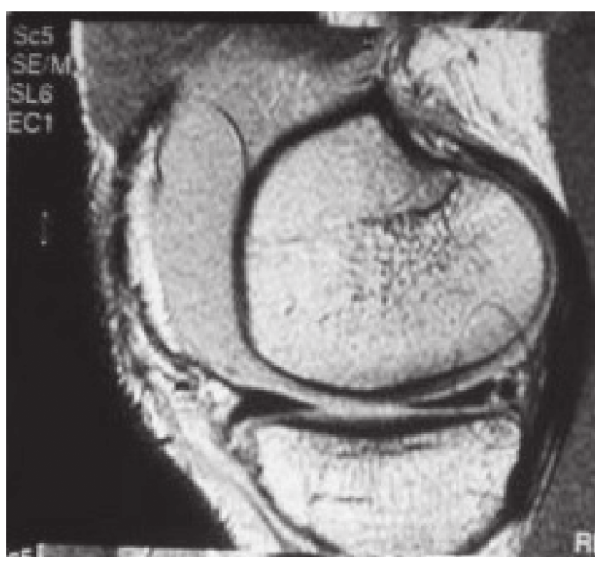
Figure 1 - NMR image showing a medial meniscal injury